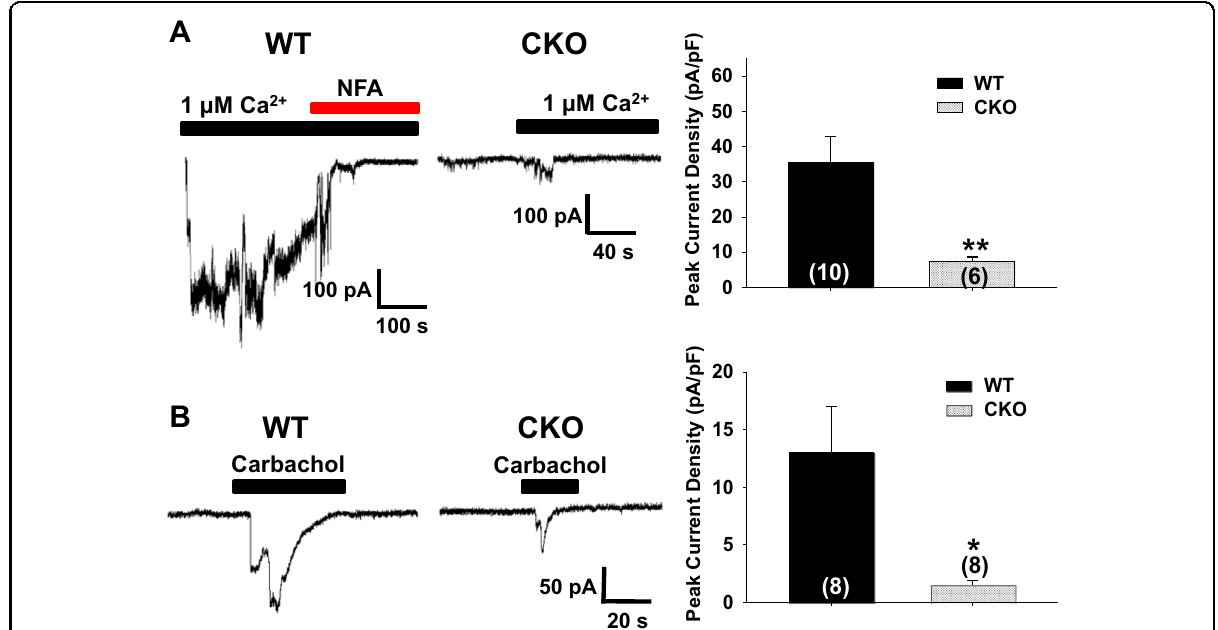
Fig. 2 Genetic ablation of Ano1 reduces Ca 2 + - and carbachol-induced Cl − currents in colonocytes isolated from Cdx2-Ano1 fl / fl mice. a Traces of whole-cell Cl − currents induced by Ca 2 + in colonocytes isolated from Ano1 fl / fl (WT) and Cdx2-Ano1 fl / fl (CKO) mice. Ca 2 + (1 μ M) was added to the pipette. The pipette solution contained 140 mM CsCl. The bath solution contained 140 mM NMDG-Cl. The holding potential was − 60 mV. Whole- cell patches were formed at the beginning of the black bar. Ni fl umic acid, a blocker of ANO1, was applied to block the ANO1 current. (Right panel) Summary of the peak current density evoked by Ca 2 + in WT and CKO colonocytes. ** p < 0.01. b Traces of whole-cell Cl – currents induced by carbachol in colonocytes from WT and CKO mice. After forming whole-cell patches, 1 mM carbachol was applied to the bath. (Right) Summary of the current density evoked by carbachol in WT and CKO colonocytes. * p <